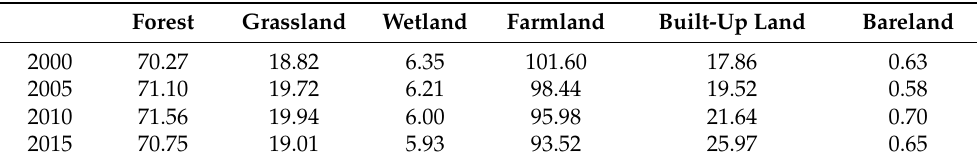
Table 1. The land cover coverage ( × 10 3 km 2 ) of the Beijng–Tianjin–Hebei (BTH) region in each period. Forest Grassland Wetland Farmland Built-Up Land